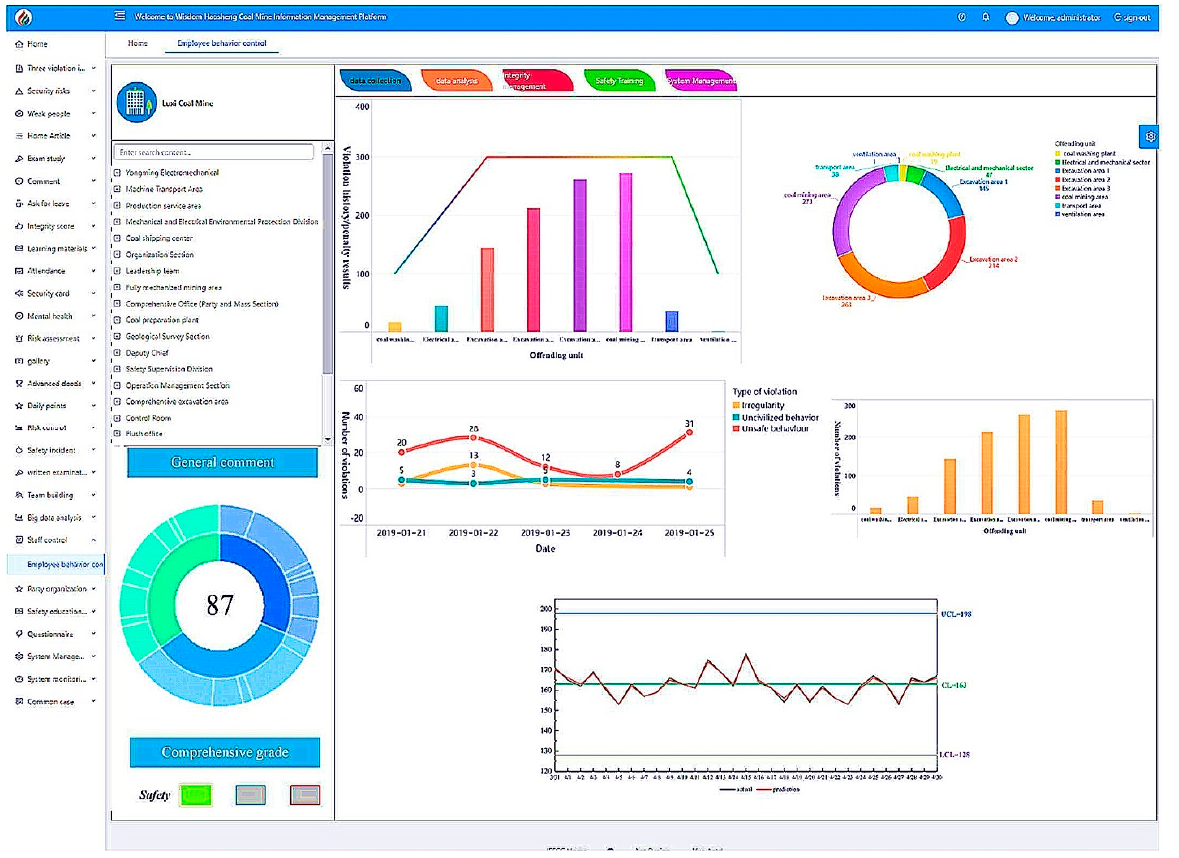
Figure 13. Coal mine risk management platform.